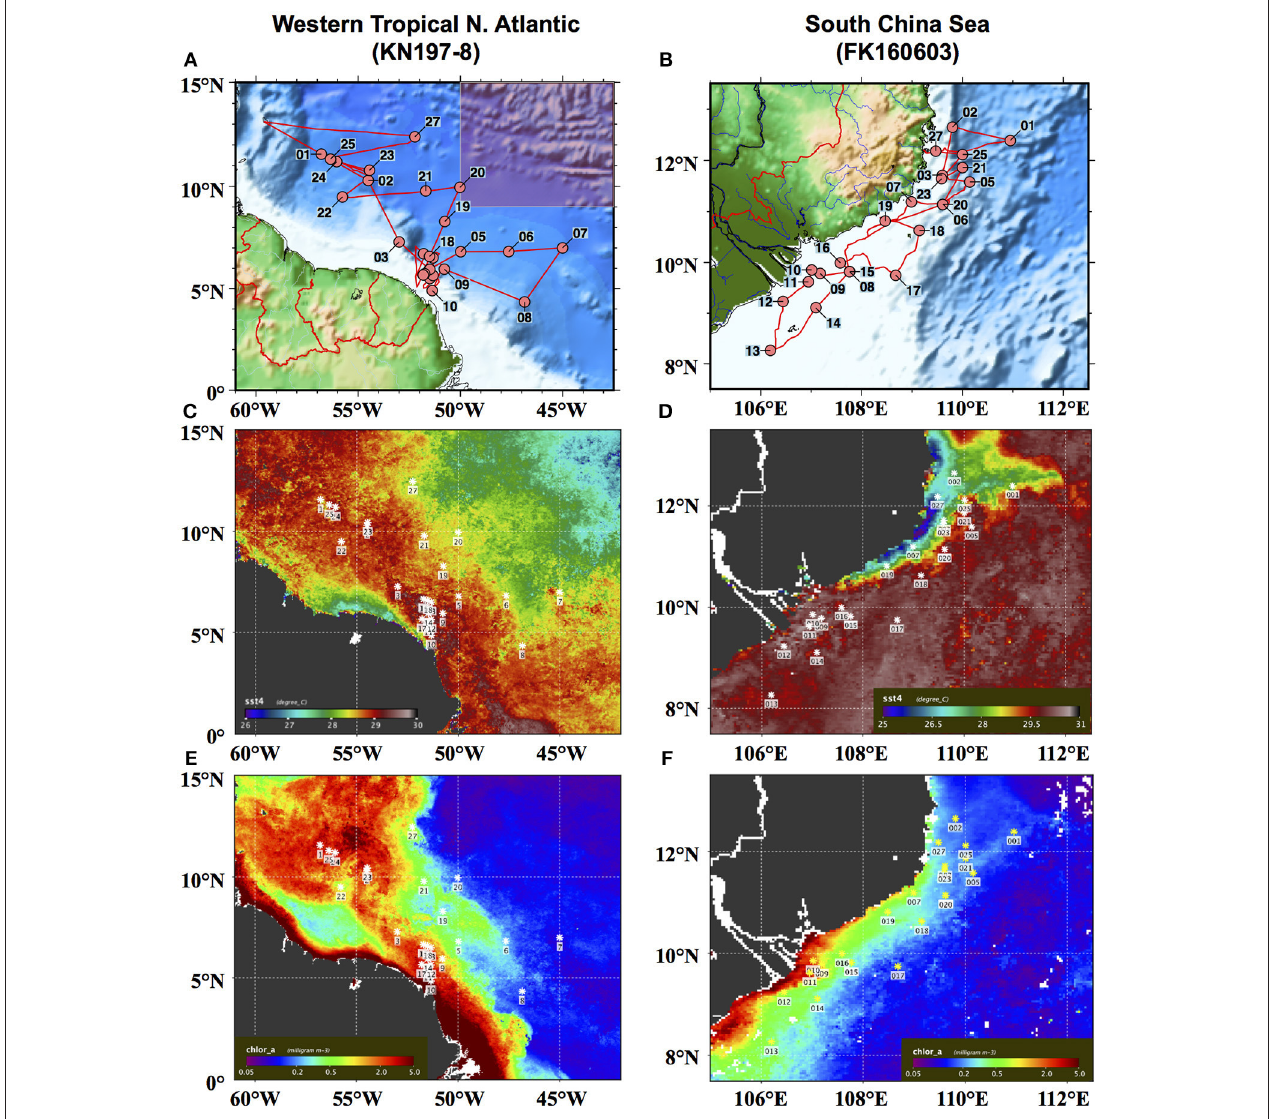
FIGURE 1 | Station maps of (A) cruise KN197-8 in May–June 2010 in the Western Tropical North Atlantic (WTNA) off the coast of northern South America and (B) cruise FK160603 in June 2016 in the South China Sea (SCS) off the coast of Vietnam. Composite satellite images of MODIS-Aqua SST (C,D) and Chl a (E,F) for the month of June 2010 in the WTNA and for the month of June 2016 in the SCS, respectively. Note that the shaded inset at the top right of (A) corresponds to the area mapped in (B)